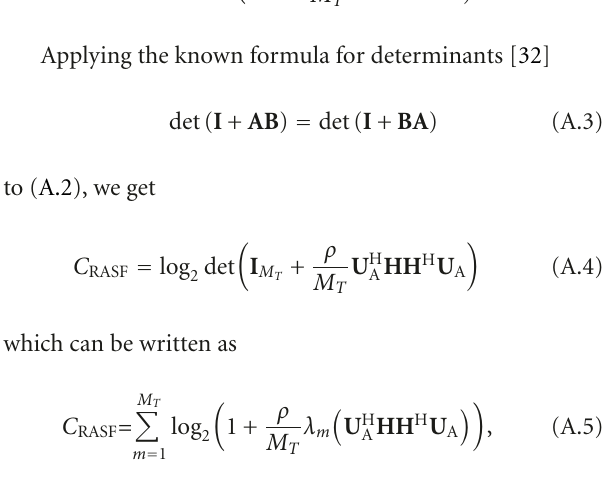
Figure 7: Performance evaluation of Frobenius-norm-based algo- rithm for several schemes of receive antenna subarray formation (RASF) applied to a 16 × 4 MIMO measured channel, in terms of er- godic capacity. In particular, the RASF schemes studied are strictly structured ASF (SS-ASF), relaxed-structured ASF (RS-ASF) (solid lines), and reduced hardware complexity ASF (RHC-ASF) (dotted lines). K denotes the number of phase shifters or/and variable gain- linear amplifiers available to the receiver. The performance of the algorithm is compared to the full system (16 × 4) and Gorokhov et al. decremental algorithm for antenna